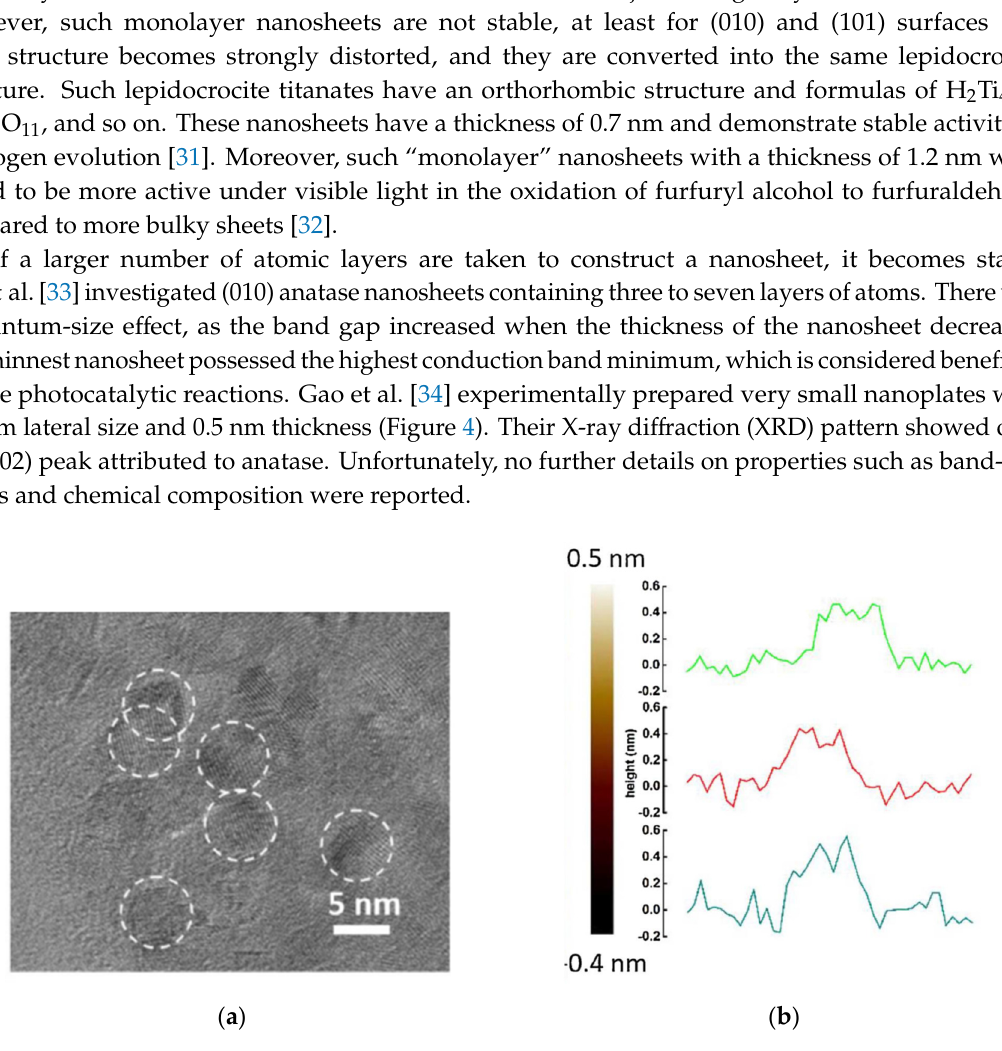
Figure 4. Experimentally prepared extremely small titania nanosheets: ( a ) high-resolution transmission electron microscopy (HR-TEM) image; The white circles indicate the presence of specific nanosheets ( b ) atomic force microscopy (AFM) thickness profile, showing the height of three particles. Reproduced from Reference [34] with permission; copyright (2017)